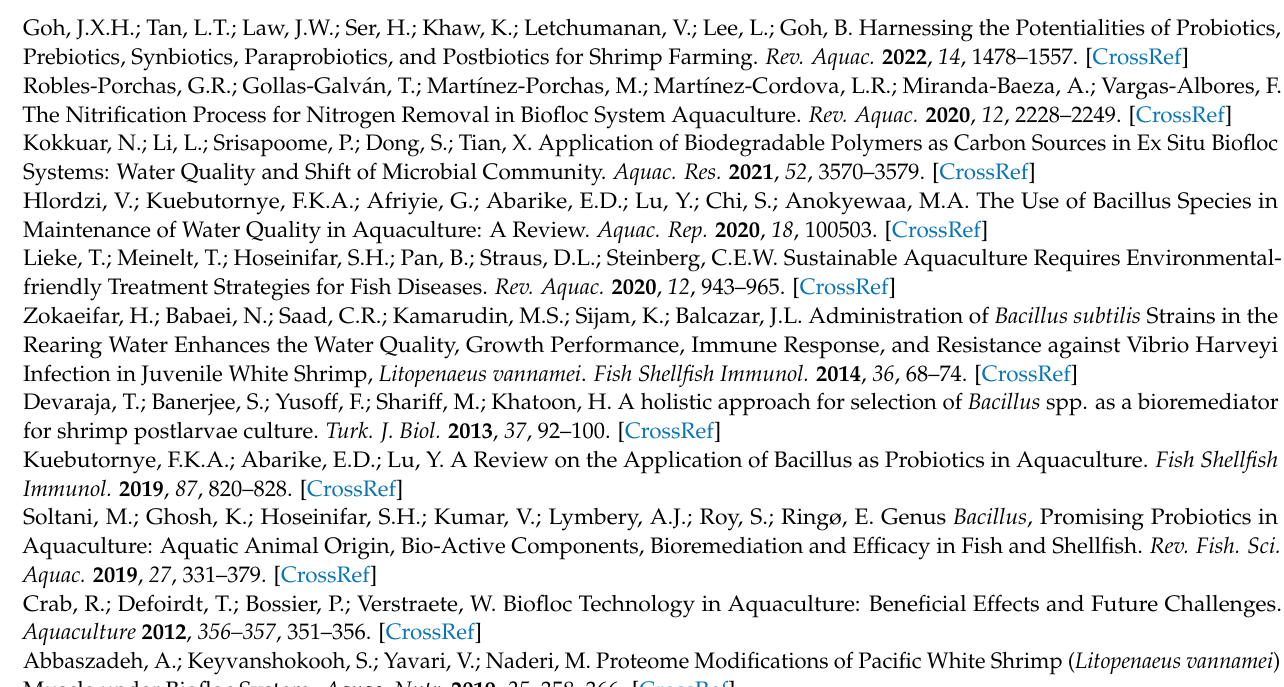
Figure S1: Analysis of rarefaction